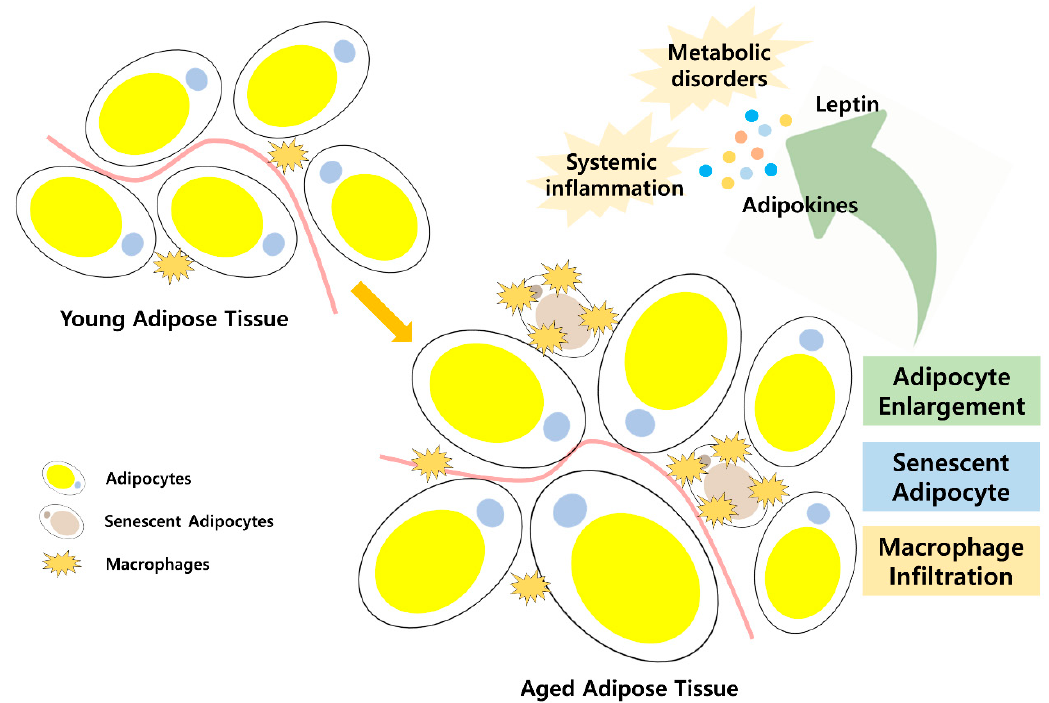
Figure 2. Changes in adipose tissue during aging and their effects to systemic aging. Compared to young adipose tissue, aged adipose tissue has enlarged, senescent adipocyte phenotype causing changes in adipokine secretion. Increase in inflammatory cells in adipose tissue secretes cytokines and chemokines that can circulate throughout the body. These changes during aging causes systemic inflammation and metabolic